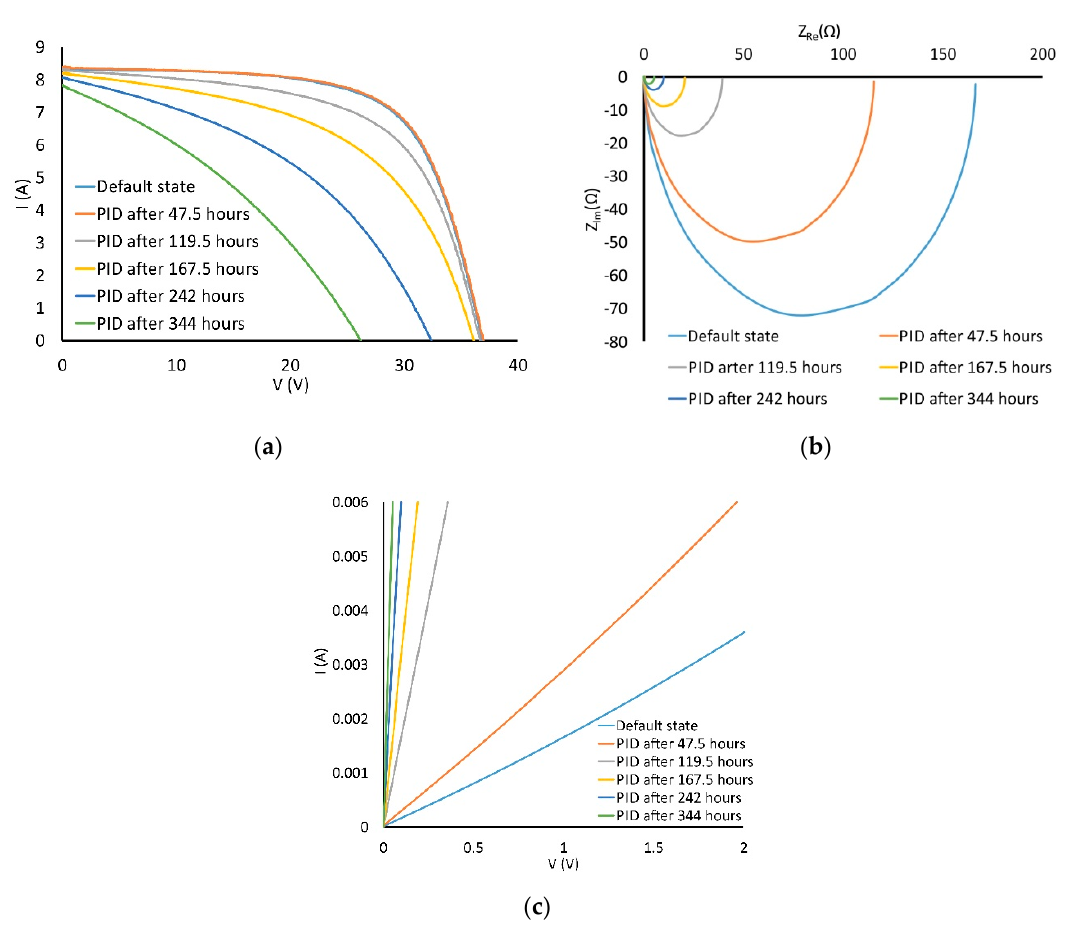
Figure 7. ( a ) I-V curves during degradation for PV module. ( b ) Cole-Cole curve during degradation for PV module. ( c ) Dark I-V curve during degradation for PV module.